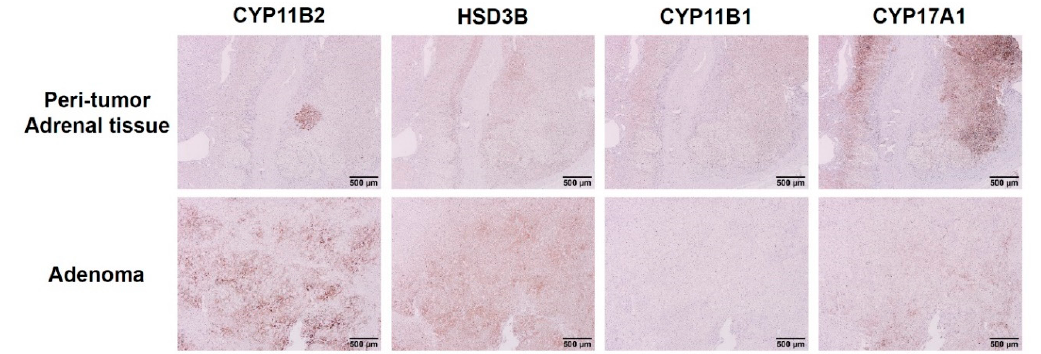
Figure 2. Immunohistochemical staining of CYP11B2, HSD3B, CYP11B1, and CYP17A1 in APA with KCNJ5 157-159delITE mutation. Comparing to the peri-tumoral adrenal tissue, the CYP11B2 and HSD3B staining were dominant in KCNJ5 157-159delITE mutant adenoma. There was no immunoreactivity of CYP11B1 and weak immunoreactivity of CYP17A1 presented in KCNJ5 157-159delITE mutated adenoma. Scale bar, 500 µ